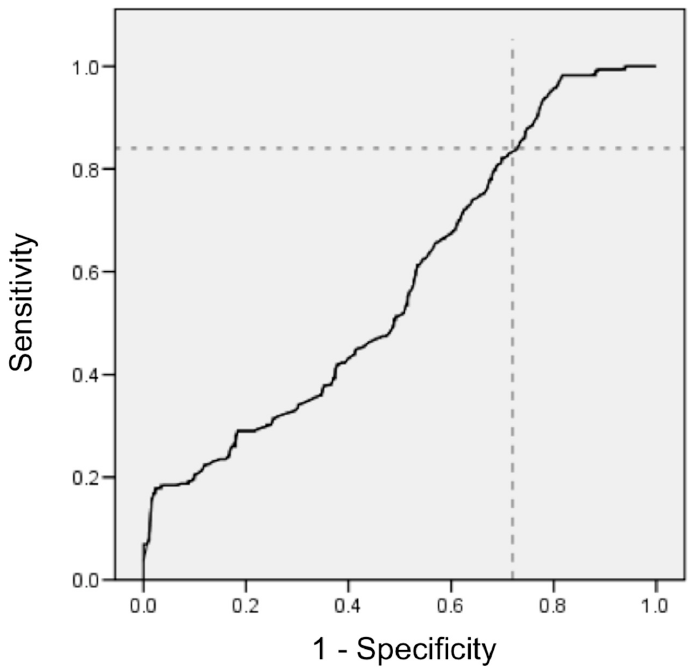
Figure 2. ROC curve plotting the sensitivity and specificity of the magnesium-to-calcium ratio and mortality from severe COVID-19.